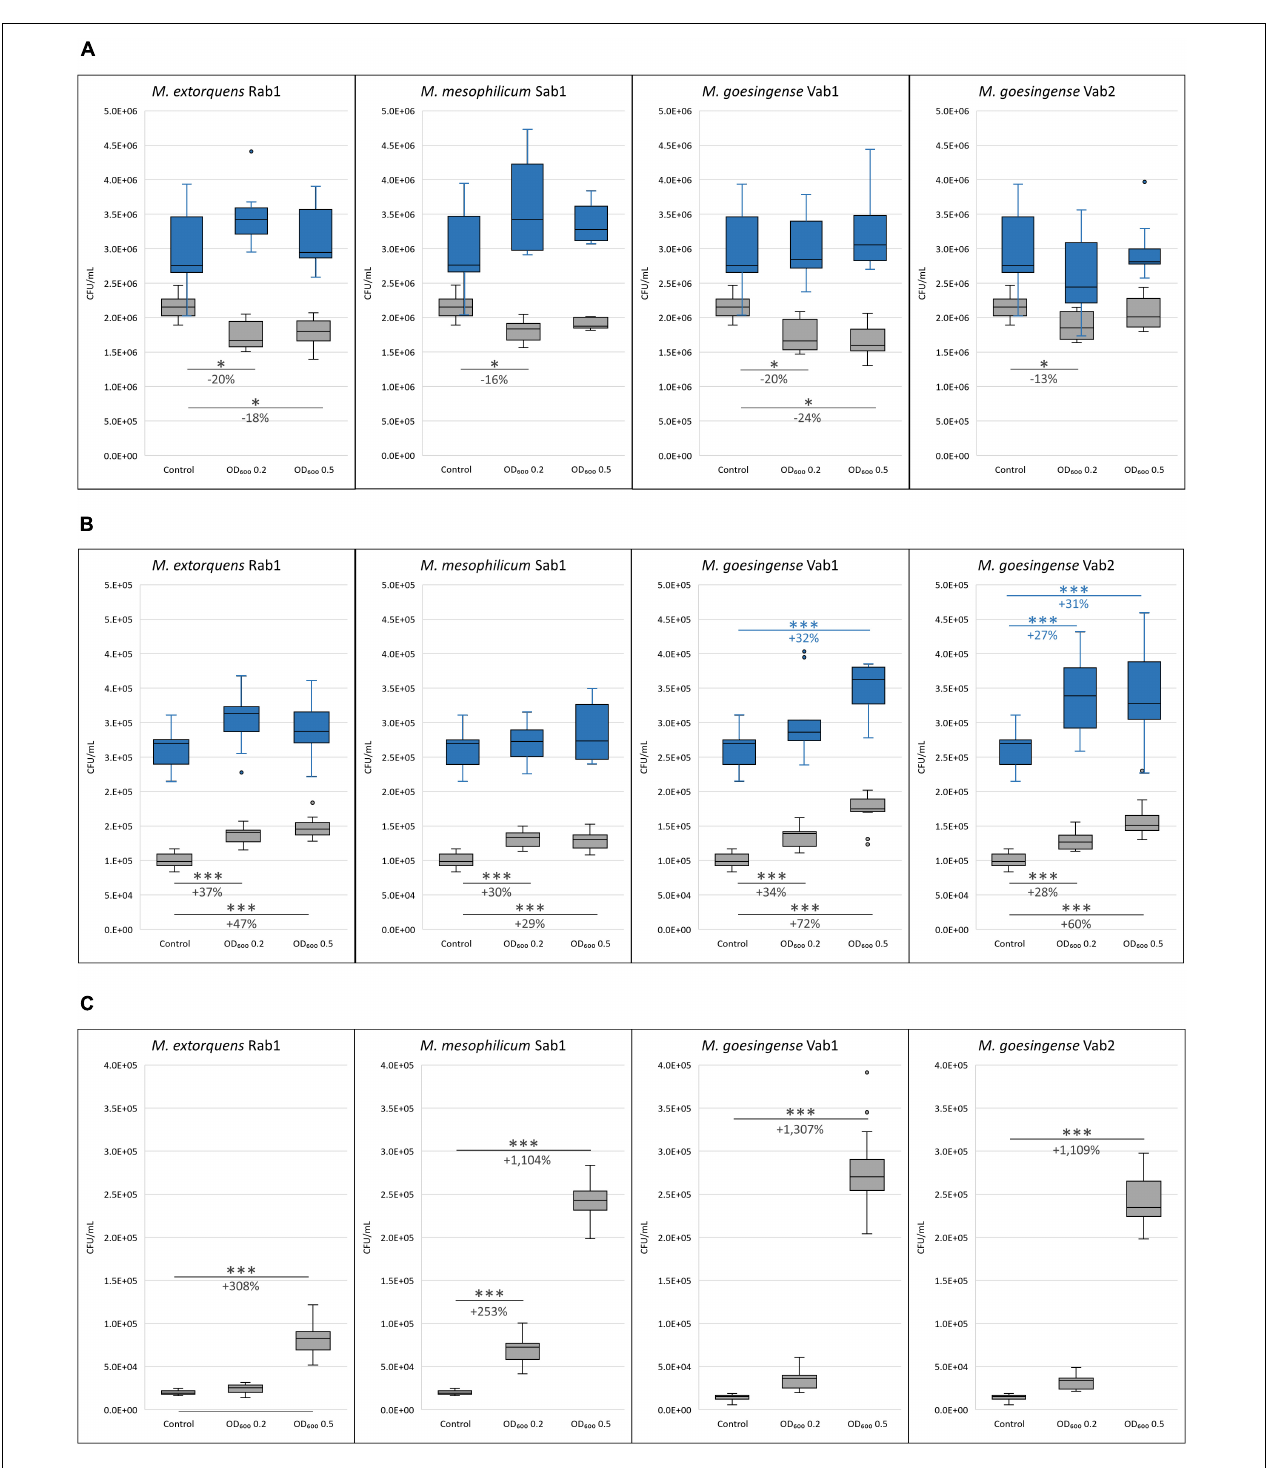
FIGURE 2 | Microalgal cell counts after seven (grsy boxes) and 14 (blue boxes) days of incubation. C. vulgaris G1-G (A) , S. vacuolatus G1-O (B) , and H. lacustris G1-R (C) were co-inoculated with four different Methylobacterium strains in two differing cell concentrations (initial cell densities: OD 600 0.2 and 0.5). Algal CFU was determined by measuring the fluorescence intensity (FI). For each box, the central line indicates the median, while the bottom and top edges of the box indicate the 25th and 75th percentiles, respectively. The whiskers extend to the most extreme data points not considered outliers. Asterisks indicate significant differences in algal cell count compared to the control ( ∗ p -value ≤ 0.05; ∗∗ p -value ≤ 0.01; ∗∗∗ p -value ≤ 0.001). The percentage of increased/reduced microalgal cell counts compared to the control is included.